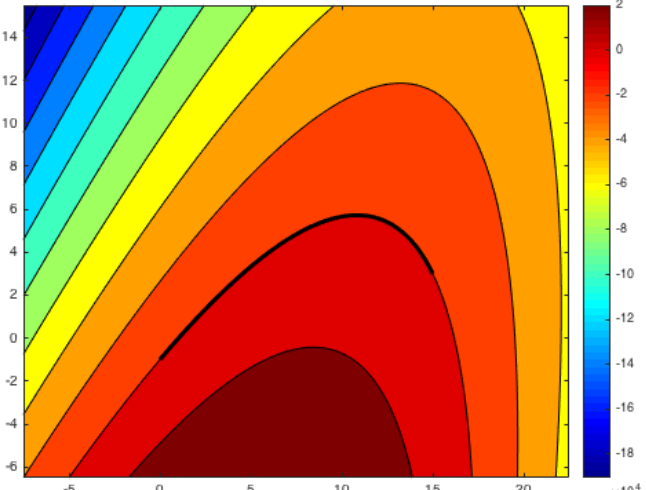
Figure 11. Implicitization of a quadratic Bezier segment. Level set Γ ( x ) = det ( M ( x )) can be used as a measure of